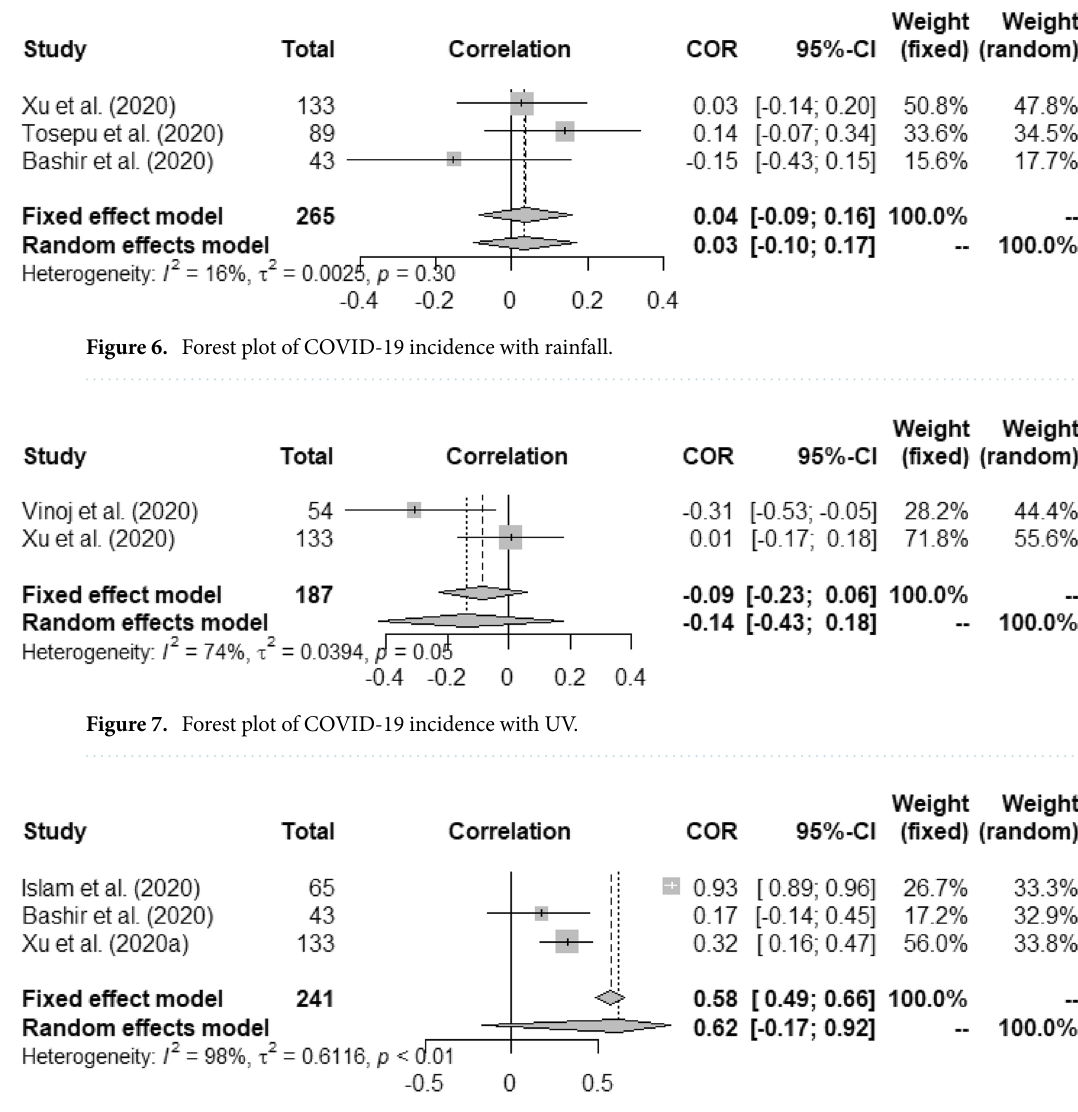
Figure 8. Forest plot of COVID-19 incidence with wind